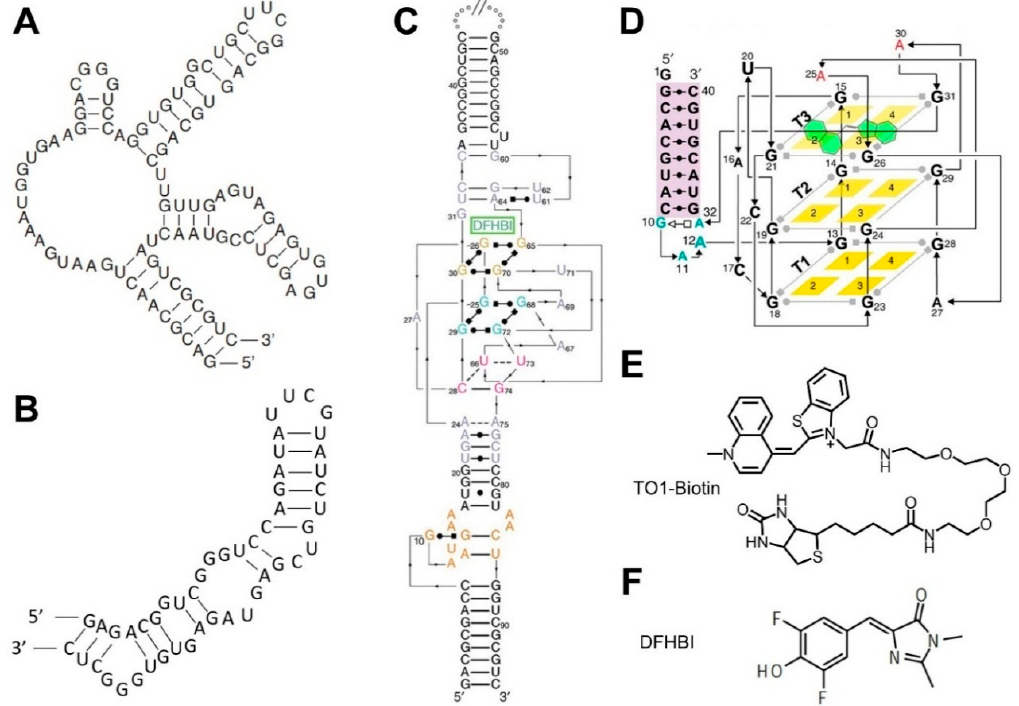
Figure 2. 2D/3D structures of fluorogenic aptamers and the chemical structures of their ligands. ( A ) Spinach aptamer 2D structure. ( B ) Broccoli aptamer 2D structure. ( C ) Spinach aptamer 3D structure [88]. ( D ) Mango aptamer 3D structure [85]. ( E ) Mango aptamer’s cognate dye TO1-Biotin. ( F ) Spinach and